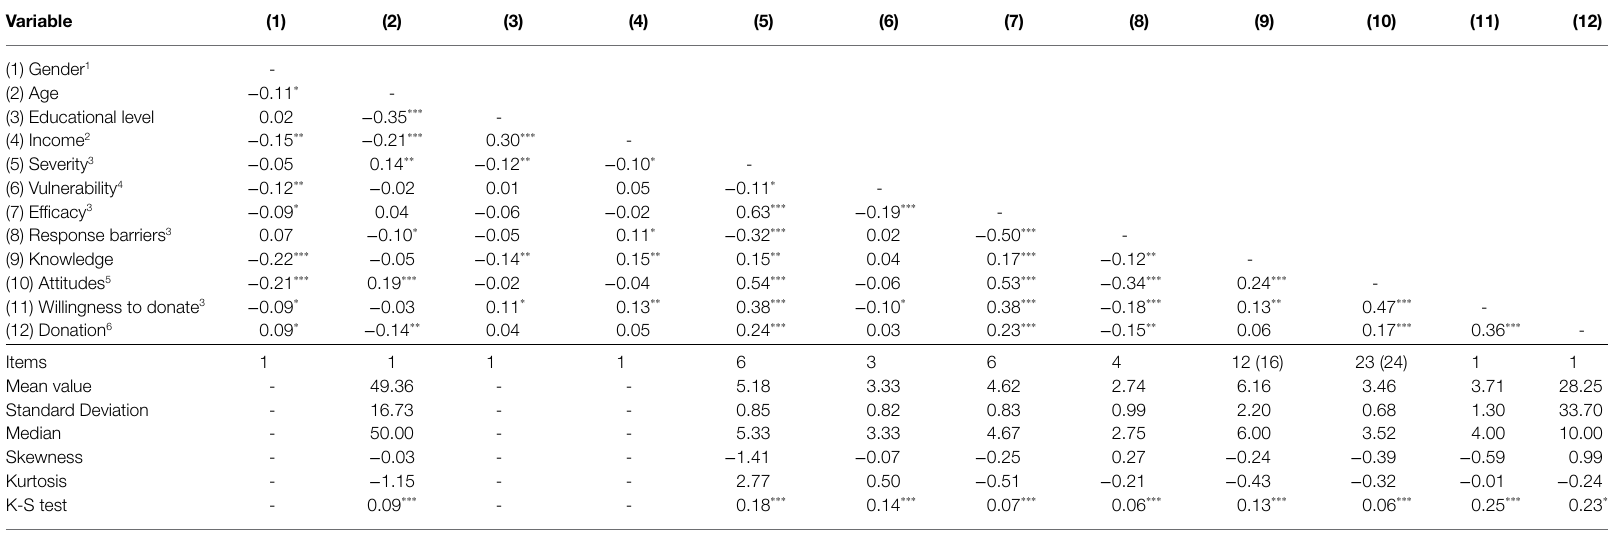
TABLE 2 | Overview of Spearman bivariate correlations and descriptive statistics of the collected variables ( N = 515).